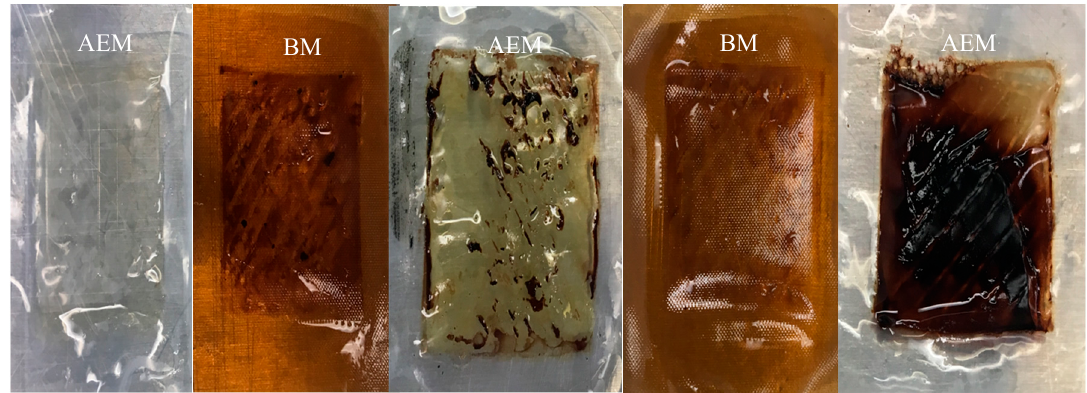
Figure 5. Hemoglobin fouling on EDBM-MCP membranes at the end of the treatment.